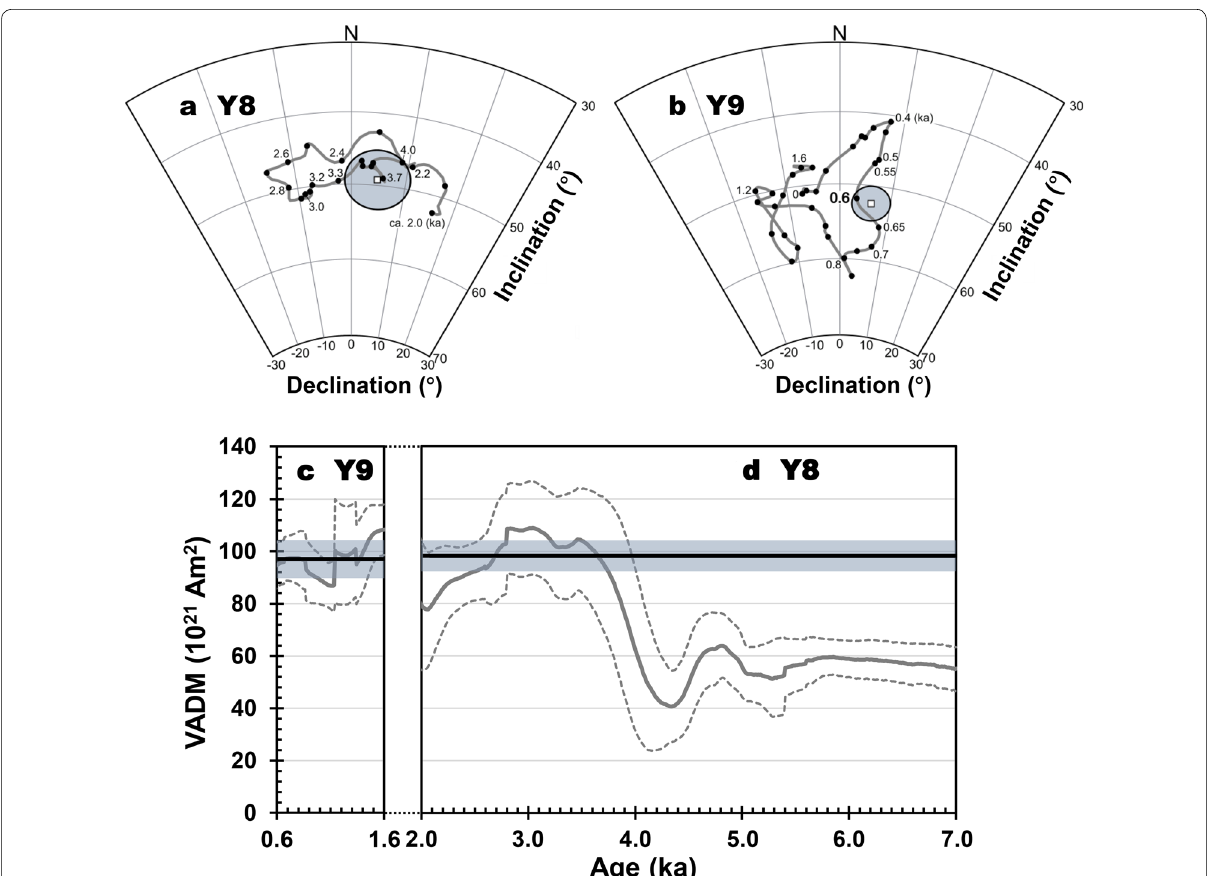
Fig. 6 PSV record during the past 4.0–2.0 ka ( a ) and 7.0–2.0 ka ( d ) for Y8 lava and 1.6–0.6 ka for Y9 lava ( b , c ) and our paleomagnetic results. Paleodirection obtained from Lake Biwa sediments (Ali et al. 1999) and that from the Japan Archeomagnetism Database (Hatakeyama and Shibuya 2012) were adopted, respectively, as PSV to paleodirection age estimation for Y8 ( a ) and Y9 ( b ) lava. Paleointensity data obtained from eastern Asia (Cai et al. 2017) were adopted as PSV for paleointensity age estimation ( c , d ). Mean paleodirections of Y8 ( a ) and Y9 ( b ) lava and their 95% confidence angles are shown, respectively, as open squares and gray circles. Estimated VADM values of Y9 ( c ) and Y8 ( d ) lava and their standard deviations are shown, respectively, as bold lines and gray bars